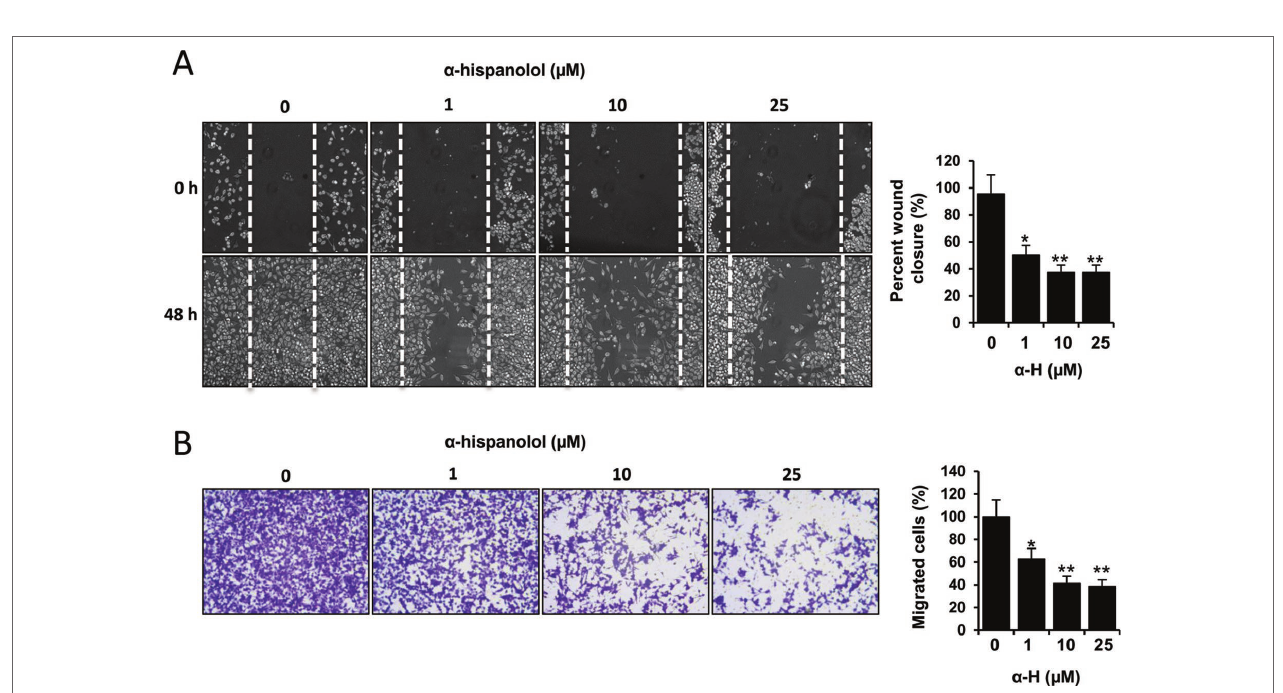
FIGURE 4 | Effects of α -H on the motility and invasiveness of U87 cells. (A) Subconfluent U87 cultures were wound scratched and then incubated in media containing varying concentrations of α -H (1, 10, and 25 μM) or vehicle as control for 48 h. Cell migration was evaluated by photomicroscopy. Representative photographs showed the same area at time zero and after 48 h of incubation with or without α -H. Bars graph represents mean ± S.D. of percentage wound closure from three independent experiments. *P < 0.05 and **P < 0.01 with respect to the non-treated cells. (B) Cell invasion was determined using a transwell assay system. U87 cells treated with indicated concentrations of α -H (1, 10, and 25 μM) or vehicle as control were seeded into the upper chamber of the system in serum- free media. The bottom well was filled with complete medium as chemotactic attractant environment. After 48 h, cells migrated to the bottom side of the filter were fixed, crystal violet stained, and evaluated by light microscopy (left panel). Magnification, ×100. Invasion rate is quantified by spectrophotometry after eluting cell staining, as described in Materials and Methods. Values represent the mean percentage of migrated cells ± S.D. from three independent experiments performed in triplicate. *P < 0.05 and **P < 0.01 with respect to the non-treated